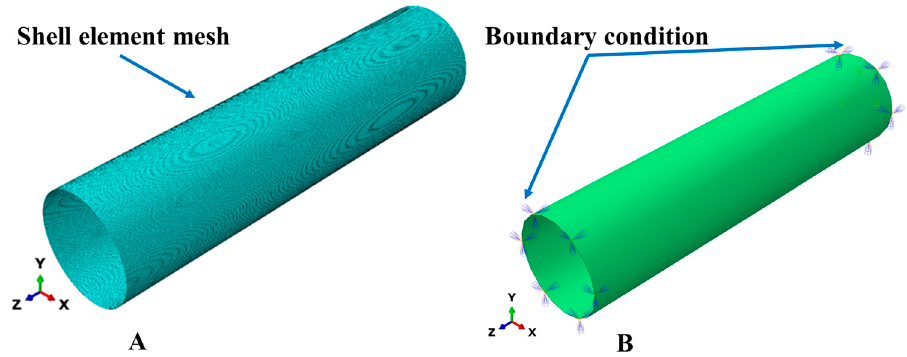
Figure 1. The flowchart of the composite pipe model is summarized in Figure 2.